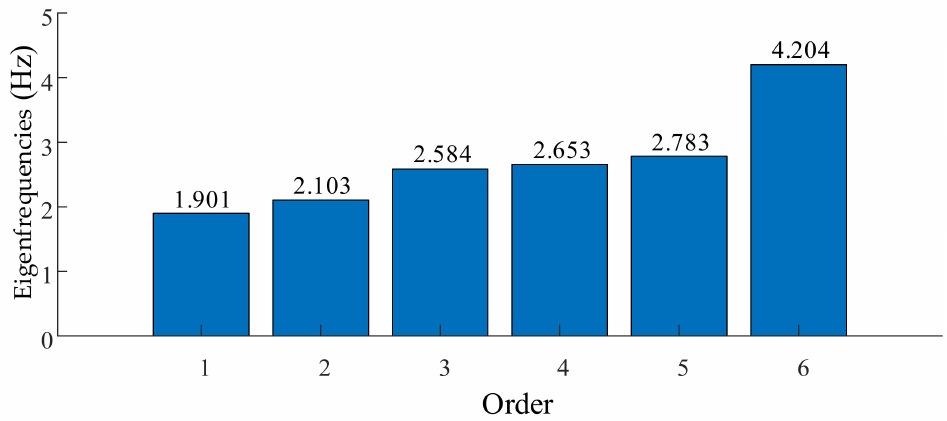
Figure 2. The first six-order